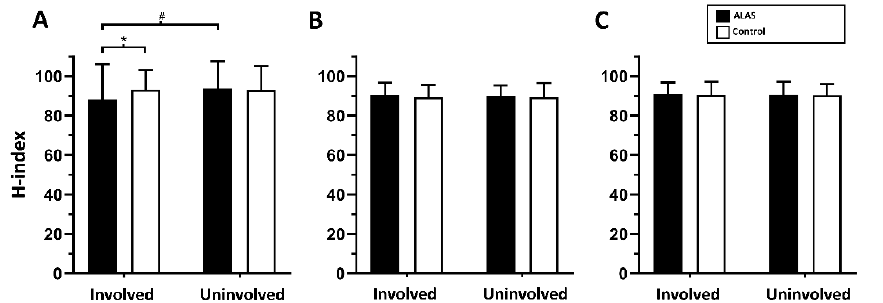
Figure 2. Comparison of H-index of the involved and uninvolved limb between two groups. Group data for soleus ( A ), fibularis longus ( B ), and tibialis anterior ( C ). * Soleus H-index of the involved limb in the acute ankle sprain group is significantly slower than that in the control group, p < 0.05. # Soleus H-index of the involved limb is significantly slower than that of the uninvolved limb in the acute ankle sprain group, p < 0.05.